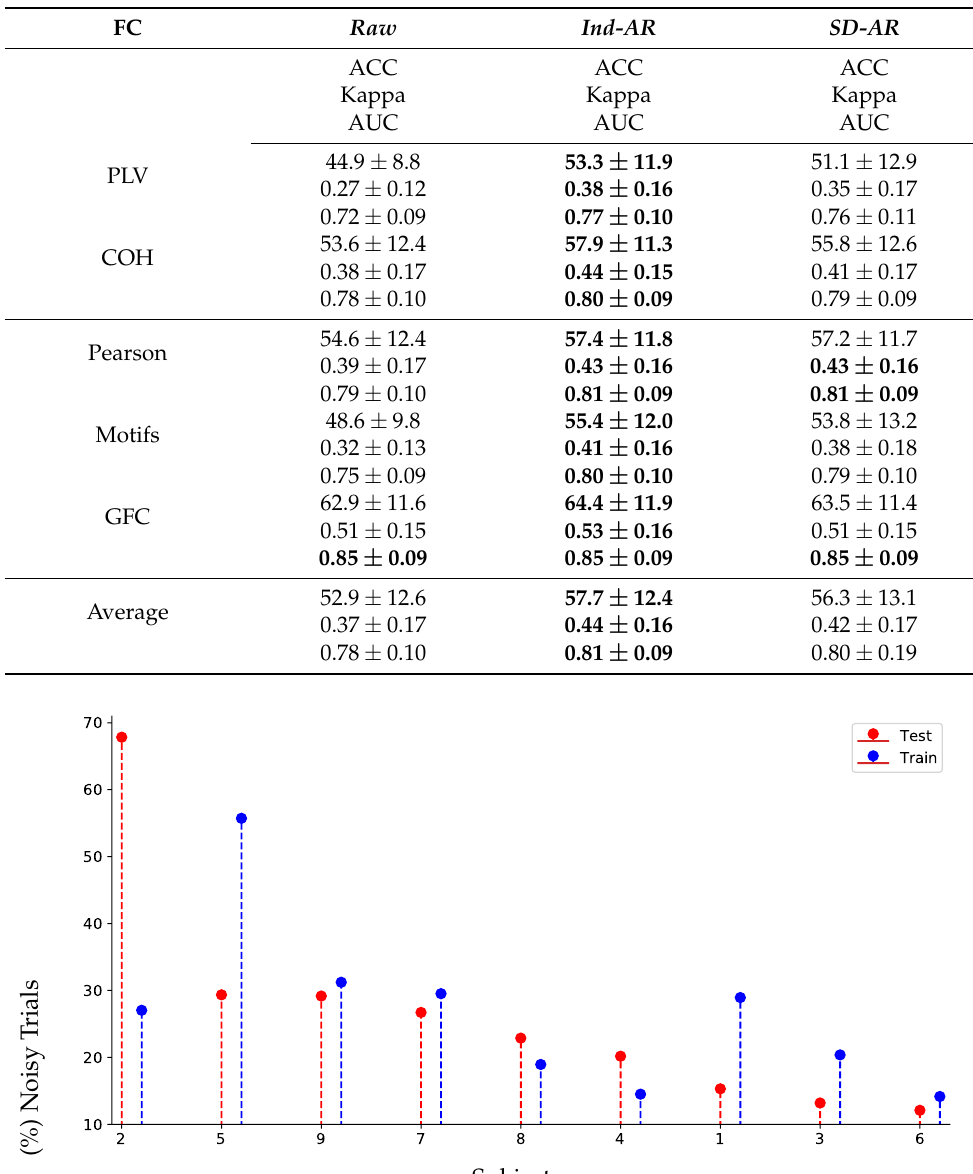
Table 1. The performance of each FC measure in DBI for each of the training classifier scenarios considered. The last row shows the performance values averaged over the whole subject set and across the evaluated FC measures. The notation PLV stands for Phase-Locking Value, COH—Spectral Coherence, Pearson—Pearson correlation, GFC Gaussian Functional Connectivity. FC: Functional connectivity. Bold stands for the best results.